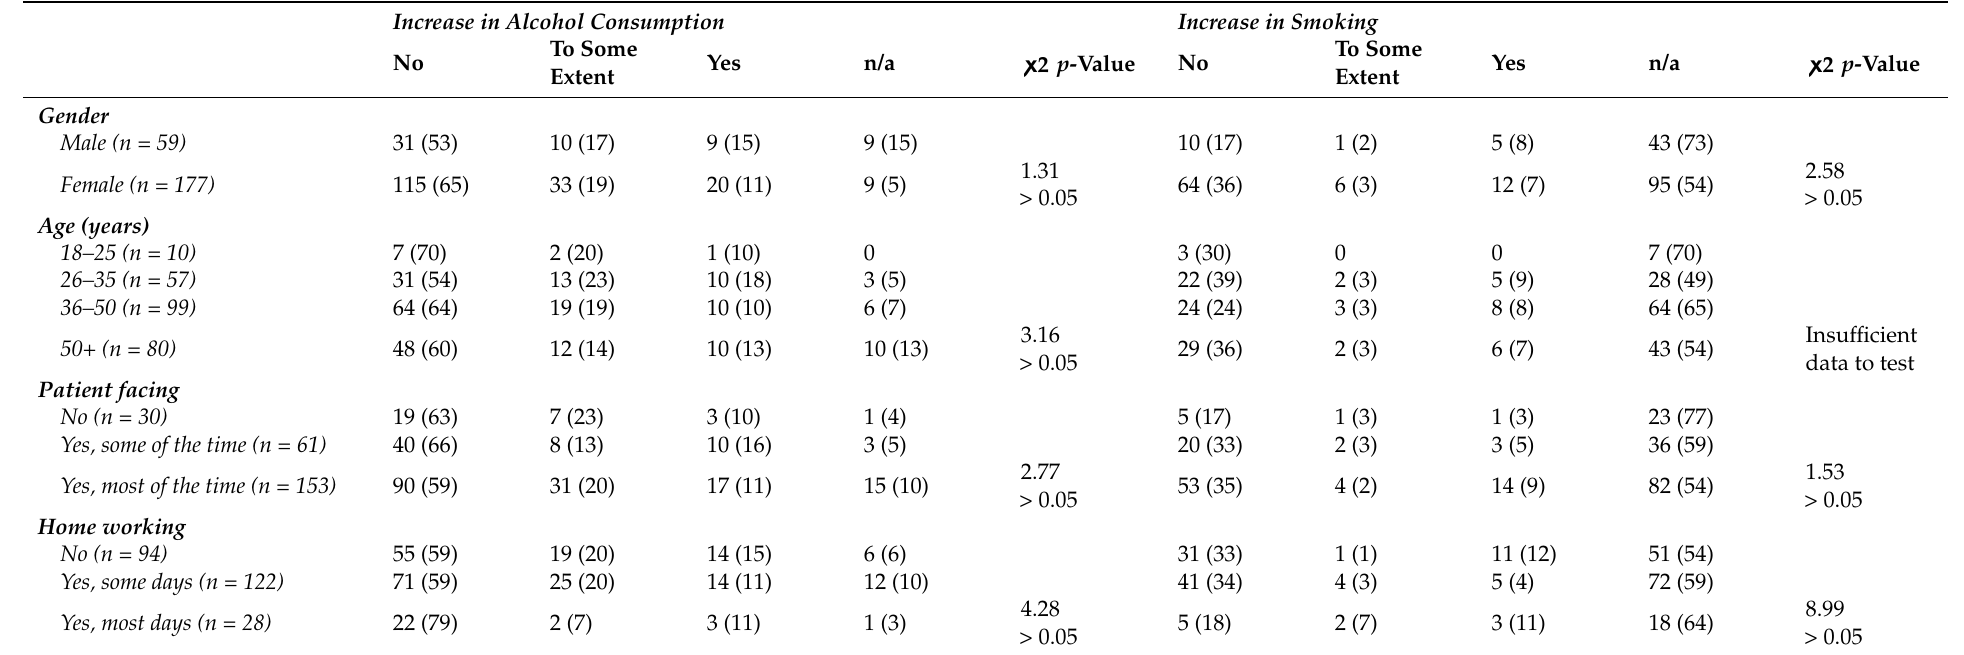
Table 1. The effect of Covid-19 on stress & anxiety, depression, and sleep in forensic staff by sample characteristics. Table 2. Substance use of forensic staff during the COVID-19 pandemic by sample characteristics. Increase in Stress & Anxiety Levels Increase in Depression Levels Difficulty Sleeping